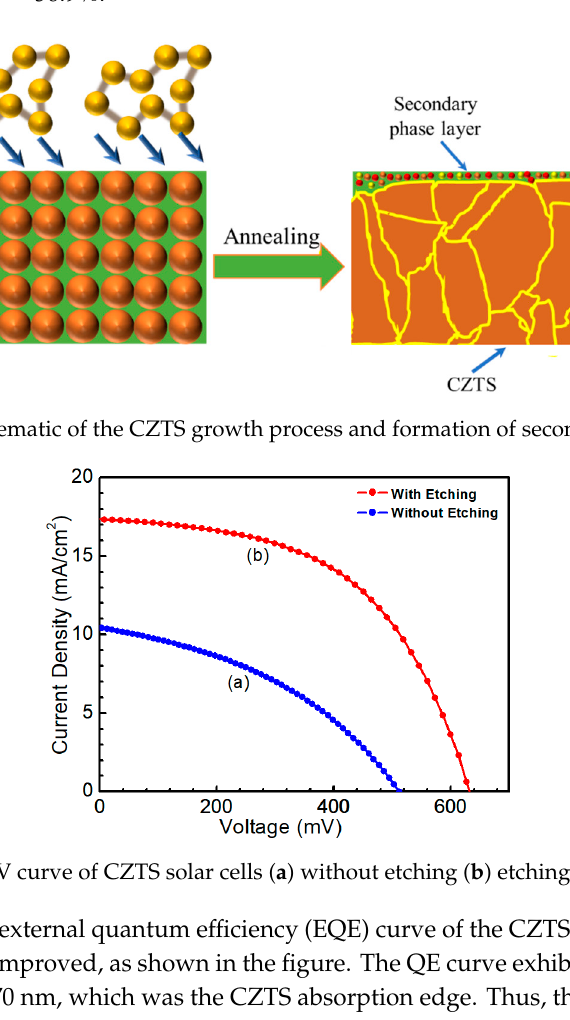
Figure 9. Auger parameters of Sn in Sn metal, CZTS and SnS compounds. The ( ), ( ), ( (